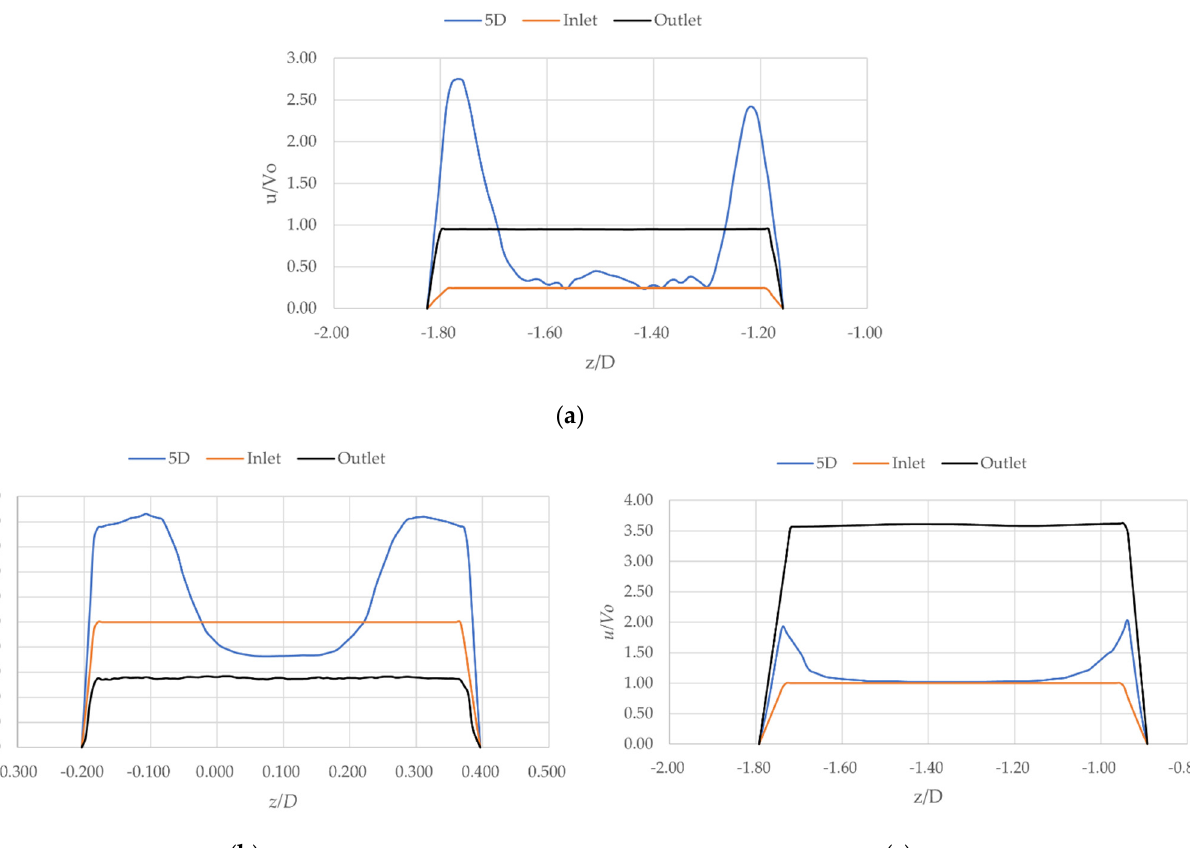
Figure 7. Streamwise velocity profiles of a multiple frame reference (5th frame) at time 0.112 s: ( a ) three blades, ( b ) four blades, and ( c ) five blades.